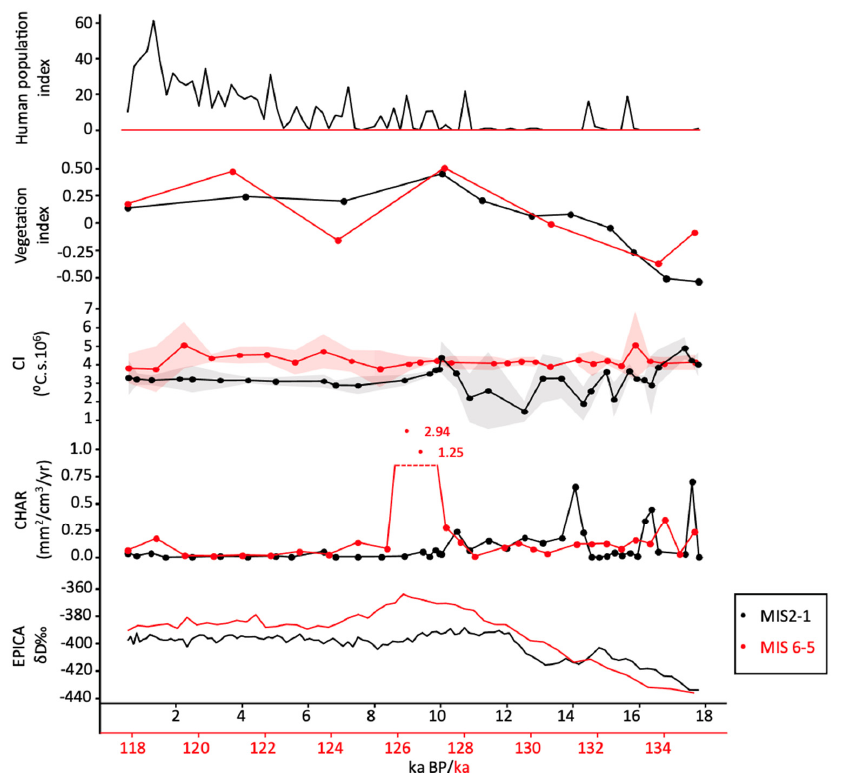
Figure 3. Overlay of MIS 6-5 (red) and 2-1 (black). Summed probability plots of archaeological data from south-eastern Australia represent an index for human activity levels [36]. Vegetation Cover represents the relationship between vegetation abundance and catchment erosion [30]. The mean Charring Intensity with 95% confidence intervals (shaded represents fire severity. The Charcoal Accumulation Rate (CHAR) or mm 2 /cm 3 /yr, represents relative biomass burnt. Changes in Antarctic temperature are represented by the ẟ D record from EPICA dome C [39].